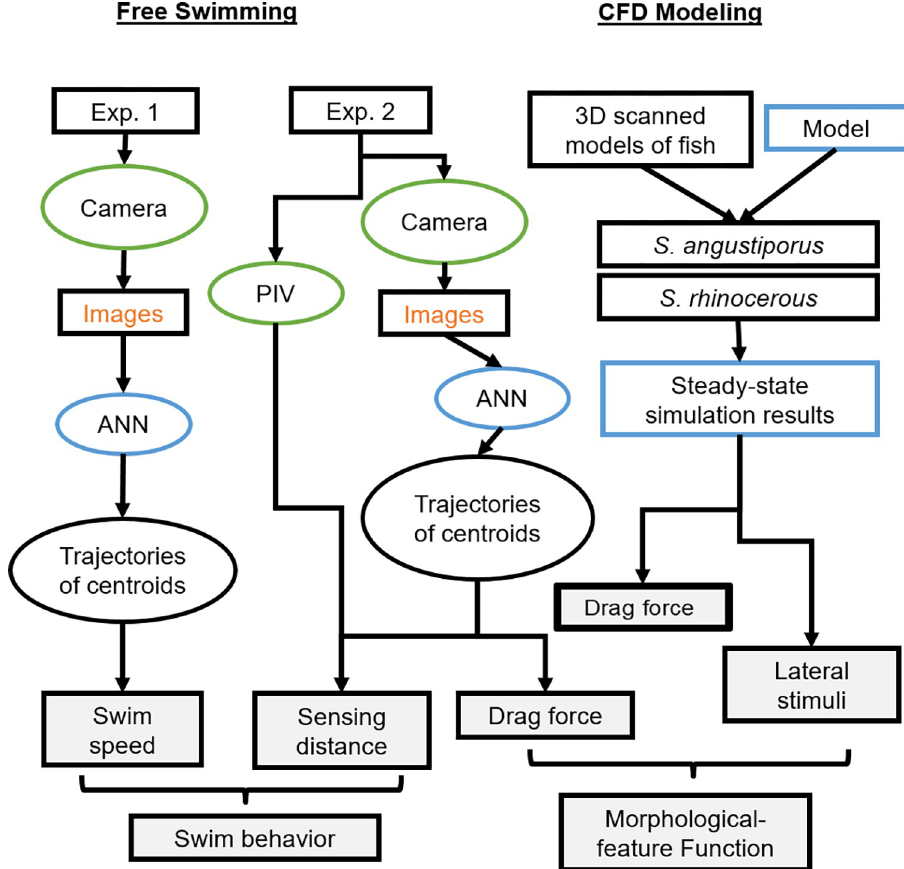
Fig 3. Technical route. Schematic depicting the experimental and analysis steps in Experiments 1 and 2 with free- swimming fish and the CFD modeling using models created by scanning preserved specimens. Gray boxes show the final response variables used in